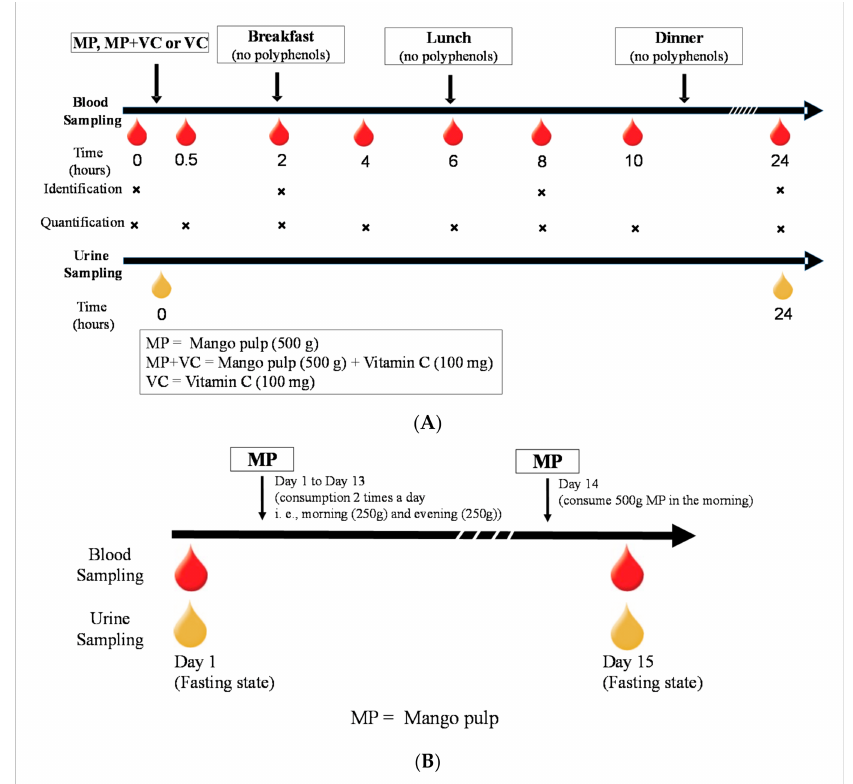
Figure 5. Blood and urine collection scheme on ( A ) an acute study day visit, ( B ) 14-day feeding